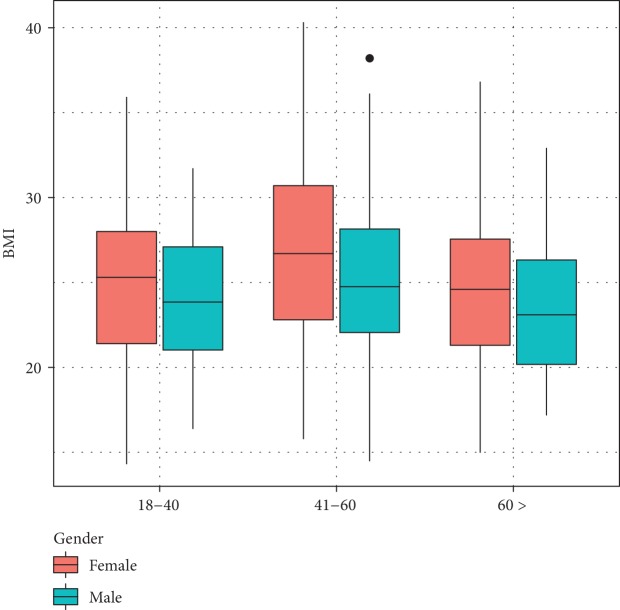
Distribution of BMI according to gender.